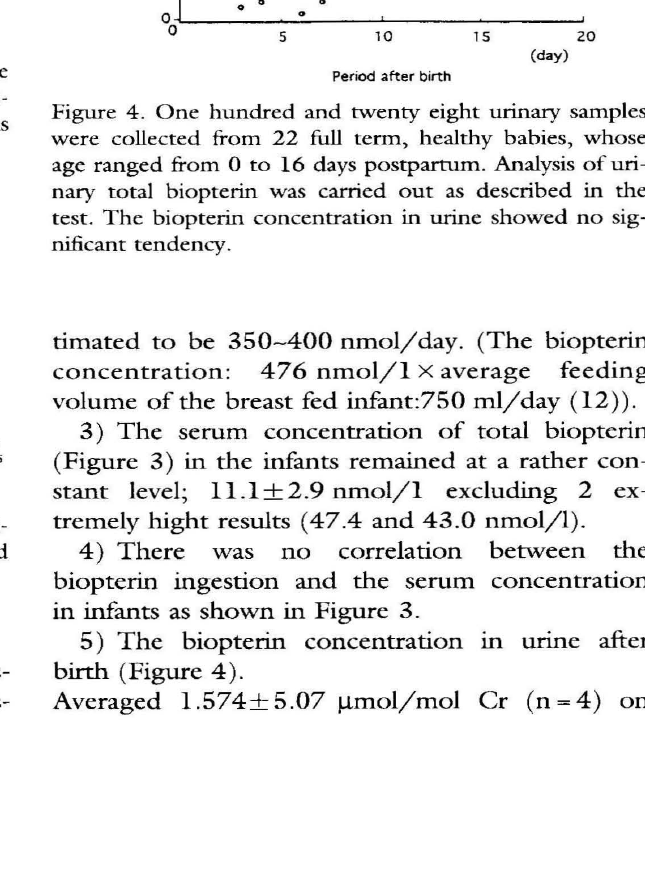
Figure lB. The mean and standrd deviation values were shown each day after parturition. When the standard de viation could not be calculated, only the mean value was shown.